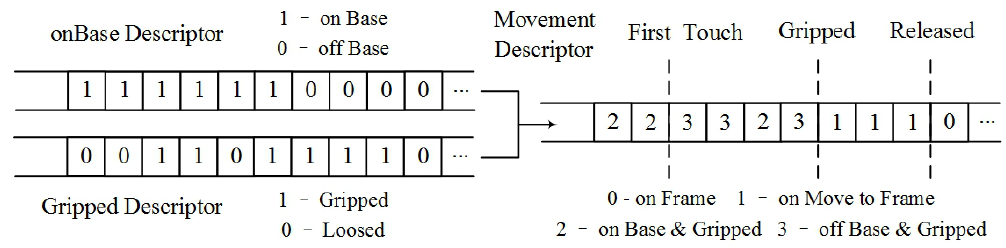
Figure 6. The bit strings for movement